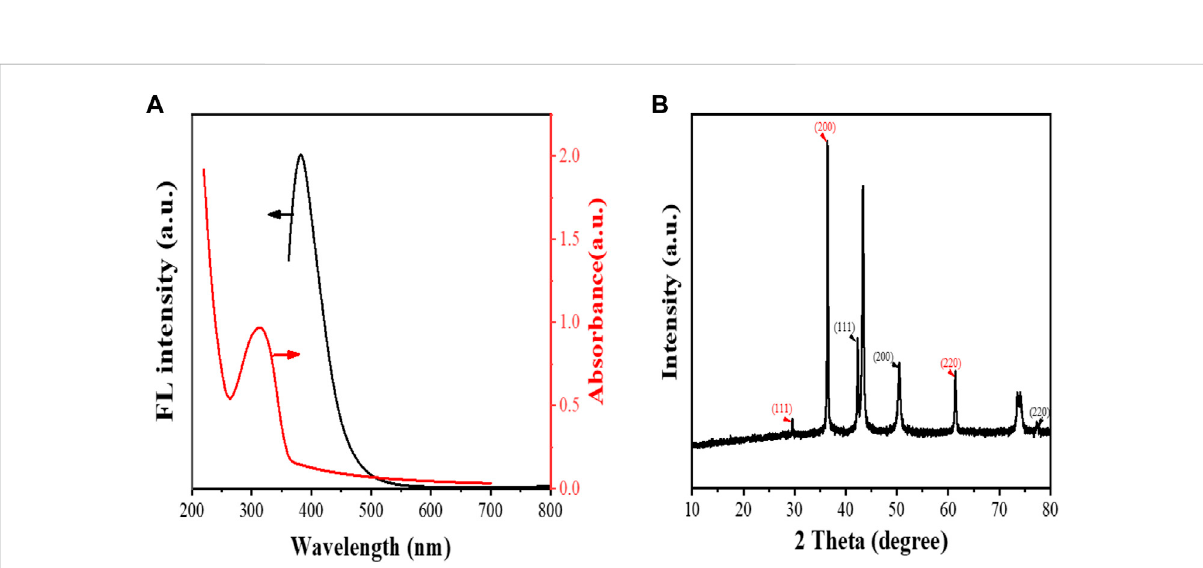
The fl uorescence and UV-Vis spectra (A) , and XRD spectra of Apt-NBs@Res@Cu 5.4 O NPs (B)